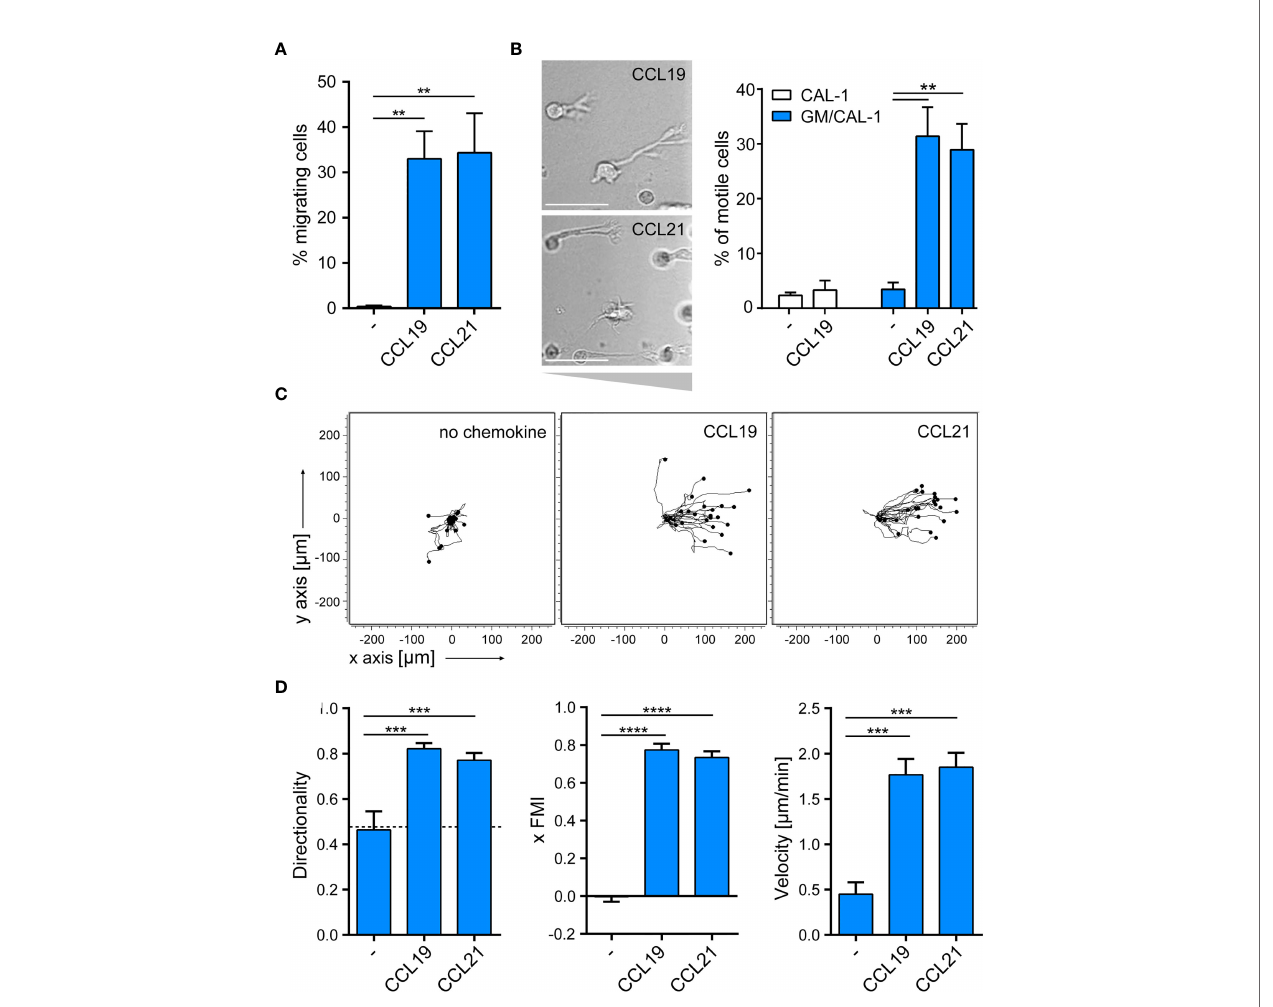
FIGURE 4 | R848-matured GM/CAL-1 cells readily migrate towards CCR7 ligands in 2D and 3D environments. (A) Mature GM/CAL-1 cells speci fi cally migrate in response to CCL19 and CCL21 in 2D Transwell migration assays. CAL-1 cells were cultured for 3 days in 10ng/ml GM-CSF followed by maturation with 10 m g/ml R848 for another 18.5h. R848-matured GM/CAL-1 cells were allowed to migrate towards medium ( – ), or 30nM of either CCL19 or CCL21 in Transwell chemotaxis chambers for 3h. Percent migrated cells was determined by fl ow cytometry. Mean values ± SD derived from n = 3 independent experiments are shown. (B – D) Mature GM/CAL-1 cells migrate directionally along chemokine gradients in 3D. R848-matured GM/CAL-1 cells were embedded into a three-dimensional collagen type I gel matrix in Ibidi µ-slide chemotaxis chambers and allowed to migrate along CCL19 or CCL21 gradients. Cell migration was monitored by time-lapse video microscopy (time lag t = 2 min). (B) Representative DIC images of migrating mature GM/CAL-1 cells are shown on the left panel. Scale bar: 50 m m. Percentage of motile CAL-1 (not treated with GM-CSF; white bars) or GM/CAL-1 (blue bars) cells in a 3D environment in the presence or absence of chemokine derived from all cells located in the entire matrix area is depicted on the right. Mean values ± SEM of at least 3 independent experiments are shown. (C) Single R848-matured GM/ CAL-1 cells randomly moving in the absence (left panel), or migrating towards CCL19 (middle panel) or CCL21 (right panel panel) from a representative experiment were tracked using an ImageJ/Fiji plug-in and individual tracks are shown in a spider plot. (D) Directionality, xFMI and velocity of individually migrating cells derived from three independent experiments were quanti fi ed. Mean values ± SEM of 3-6 independent experiments are shown. At least 10 cells per condition for every experiment, and a total of 65, 112 or 92 cells were analyzed for steady state (in the absence of chemokine), CCL19- or CCL21- directed migration,